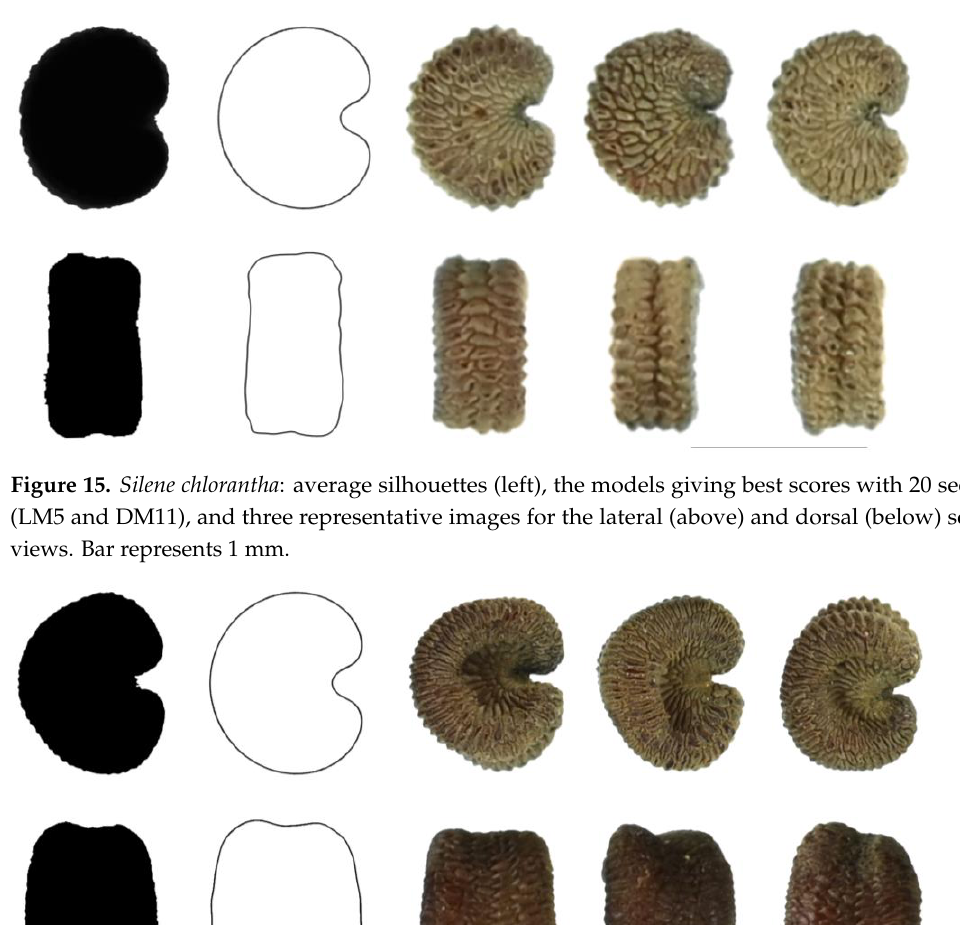
Figure 14. Silene squamigera subsp. vesiculifera : average silhouettes (left), the models giving best scores with 20 seeds (LM5 and DM6), and three representative images for the lateral (above) and dorsal (below) seed views. Bar represents 1 mm.